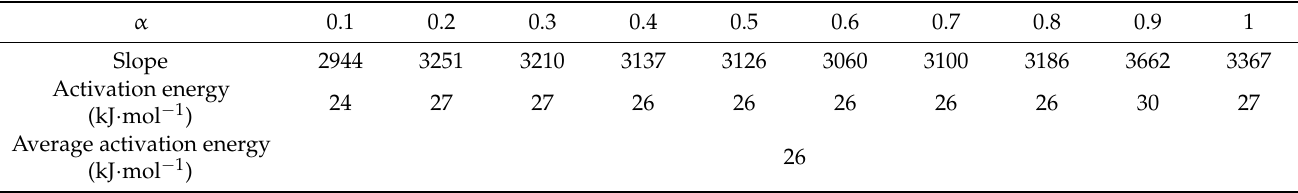
Table 6. Apparent activation energy of iron ore fines in different reduction degrees.